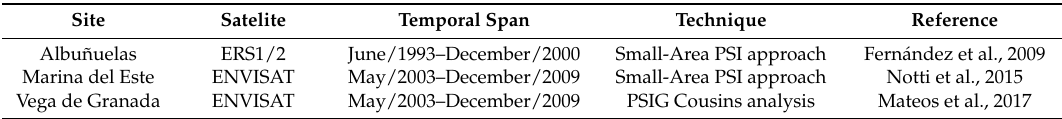
Table 2. Characteristics of the InSAR analysis used to check the GEP results.